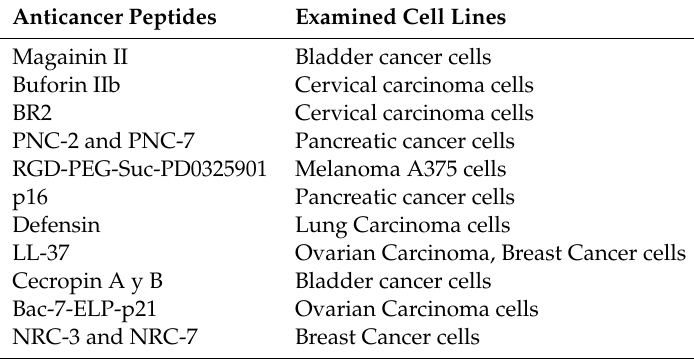
Table 1. Anticancer peptides and examined cell lines [12,43,44].